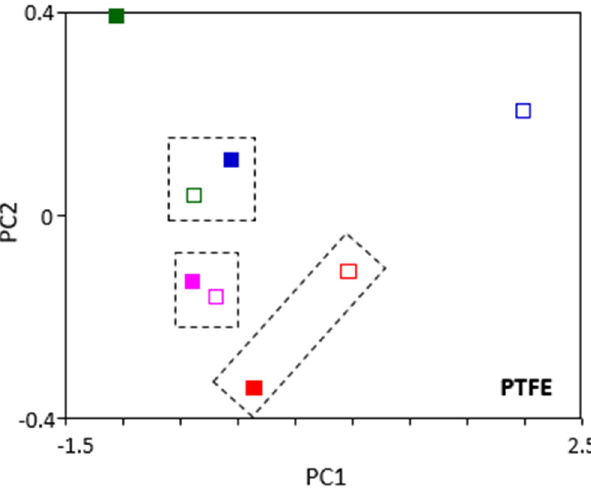
Figure 7. PCA analysis of the FT-IR spectra of the PTFE (oil A (blue), oil B (green), oil C (fuchsia), oil D (red), 672 h (empty markers) and 168 h (solid markers)).